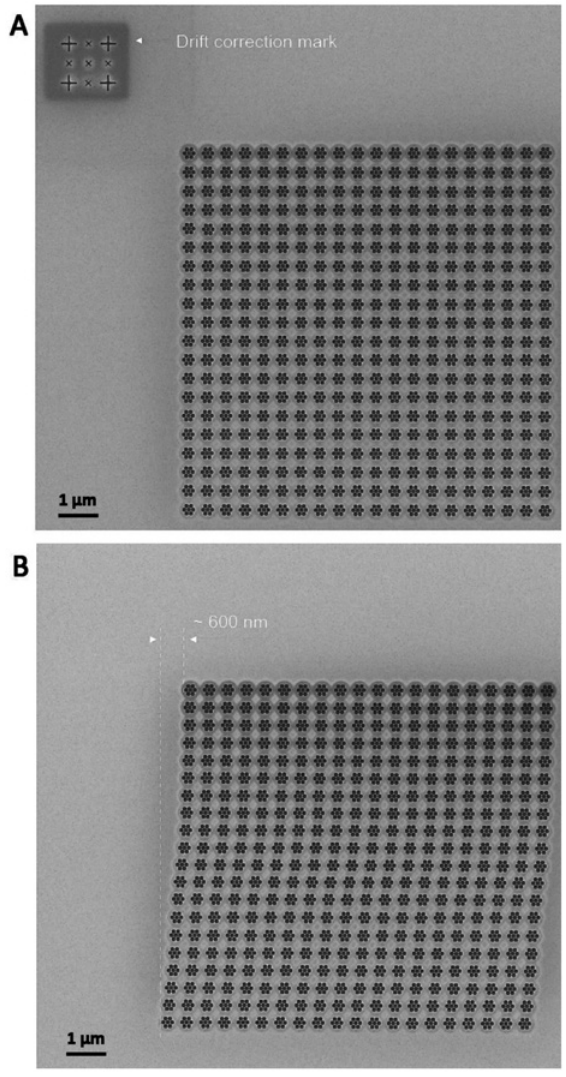
Figure 2: HIM images of 20 × 20 arrays of Au HNHs. (A) Array fabricated with drift correction. (B) Array fabricated without drift